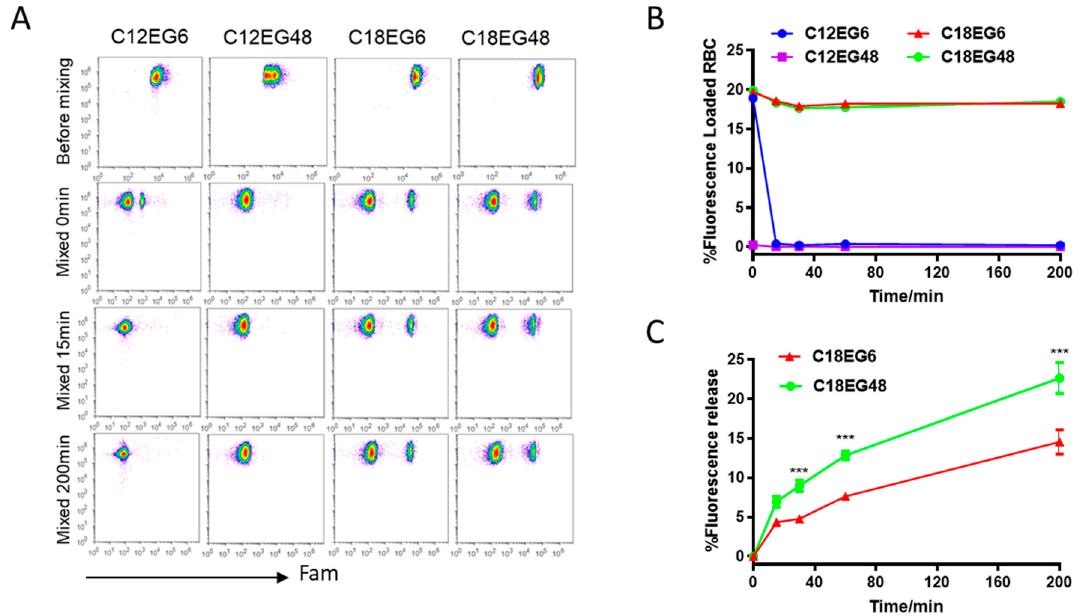
Figure 1. Kinetic stability of lipo-PEGs with varying length of lipid and PEG on RBC surface. ( A – C ), mouse RBCs were loaded with different Fam-labeled lipo-PEGs and cocultured with fleshly isolated mouse blood. The decay of fluorescence on RBC surface was quantified by flow cytometry. ( A ) Dot plot of RBC at different time points. ( B , C ) Time dependent Fam-positive frequencies ( B ) and relative mean fluorescence intensities ( C ) of RBCs. Each sample was assayed with three replicates. Error bars represent the SEM. Data show the mean values ± SEM. *, p < 0.05; **, p < 0.01; ***, p < 0.001; ****, p < 0.0001; ns, not significant.